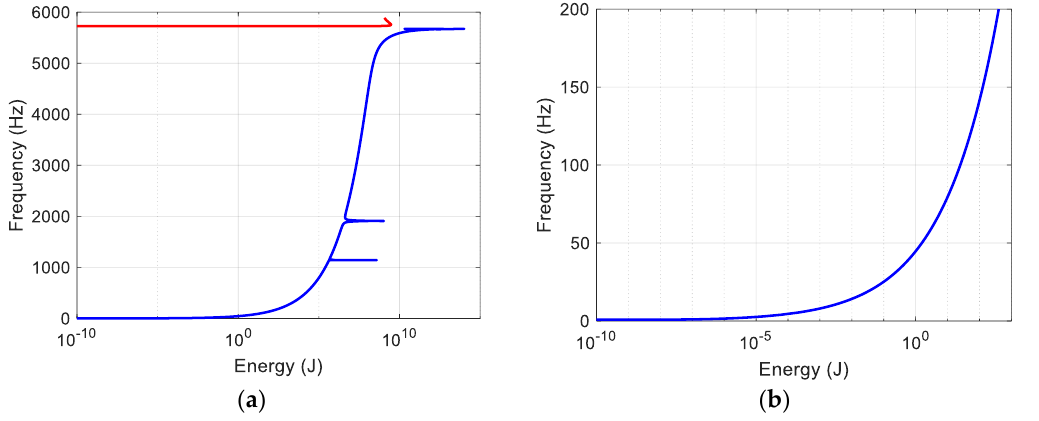
Figure 2. ( a ) NNMs without the rigid body mode and using the average meshing stiffness; ( b ) zoom-in for the first mode in the experimentally observed frequency range.